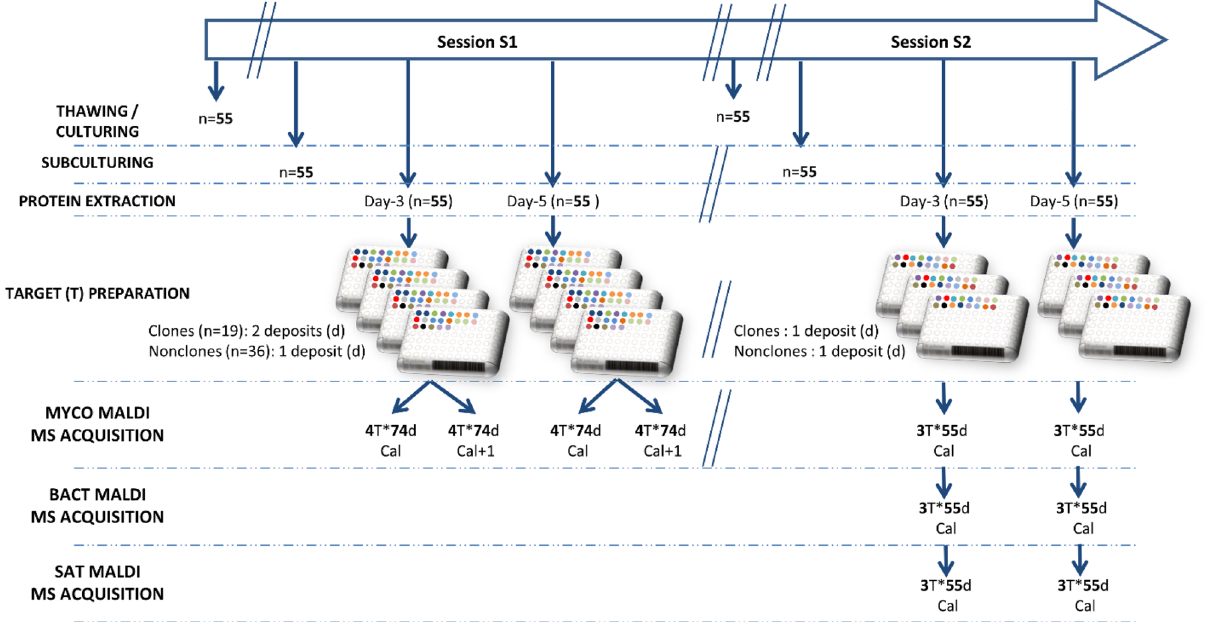
Figure 1. Culture and spectral acquisition workflow for both training (S1) and testing (S2) phases. T = Target, d = deposit, Cal = Microflex calibration of the day, Cal + 1 = Microflex calibration of the day after. In the MS Acquisition lines, 4 T*74d means that 74 deposits were made on 4 Targets. MYCO (mycology department), BACT (bacteriology department) and SAT (Saint Antoine hospital) correspond to the laboratories where the three MALDI TOF instrument used for this study are